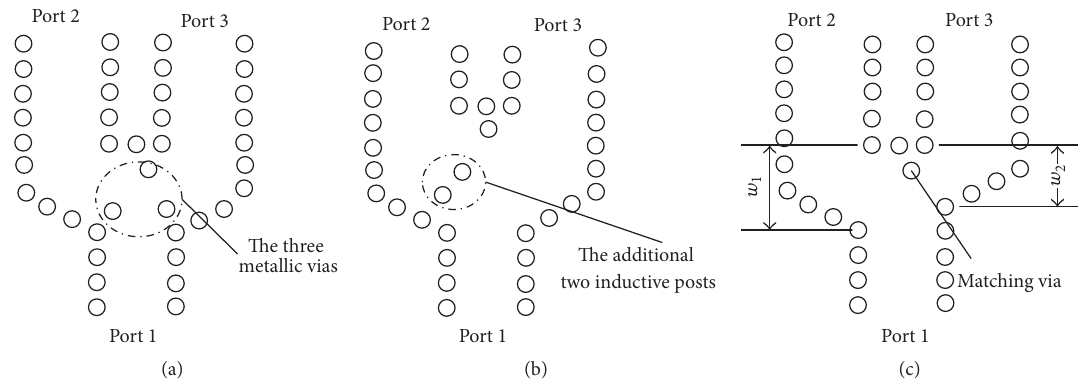
Figure 4: Different types of unequal dividers. (a) Structure in [9]; (b) structure in [10]; (c) our structure.